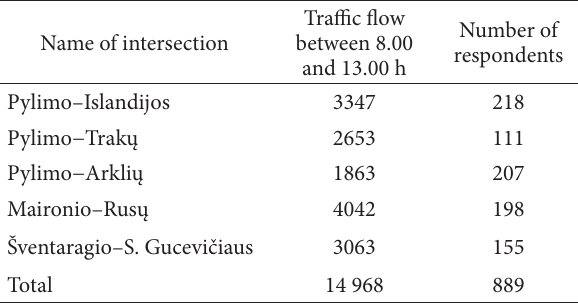
Table 1. Traffic flow on main entrances to Old Town and